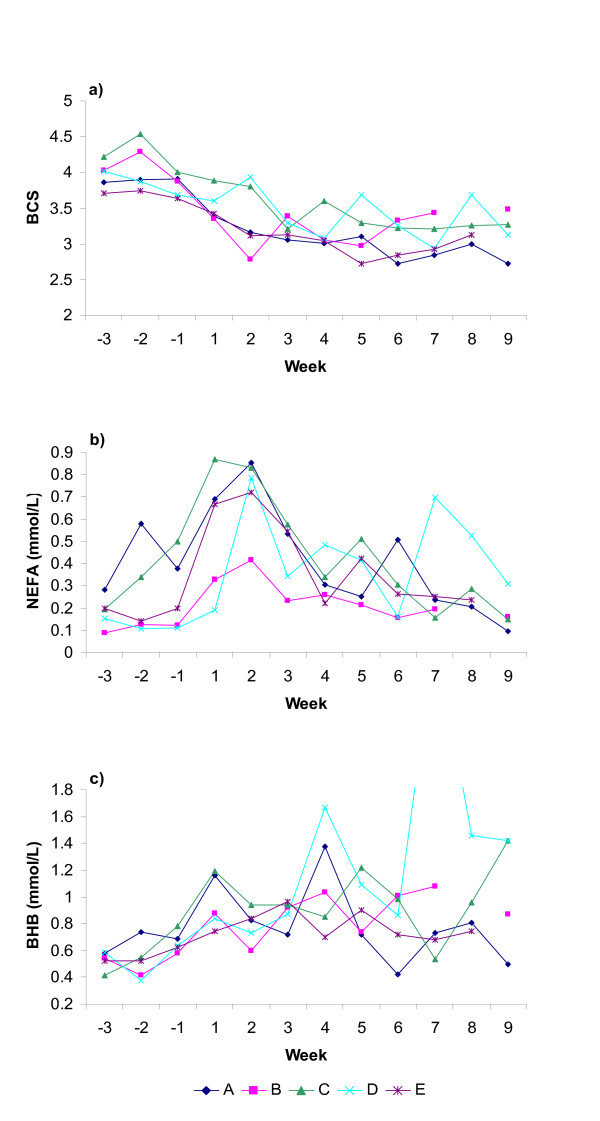
Herd-specific patterns for herd A-E shown as least-squares means. a) body condition score (BCS), b) non-esterified fatty acids (NEFA) and c) β-hydroxybutyrate (BHB). The BHB peak week 7 in herd D was 2.95 mmol/L.